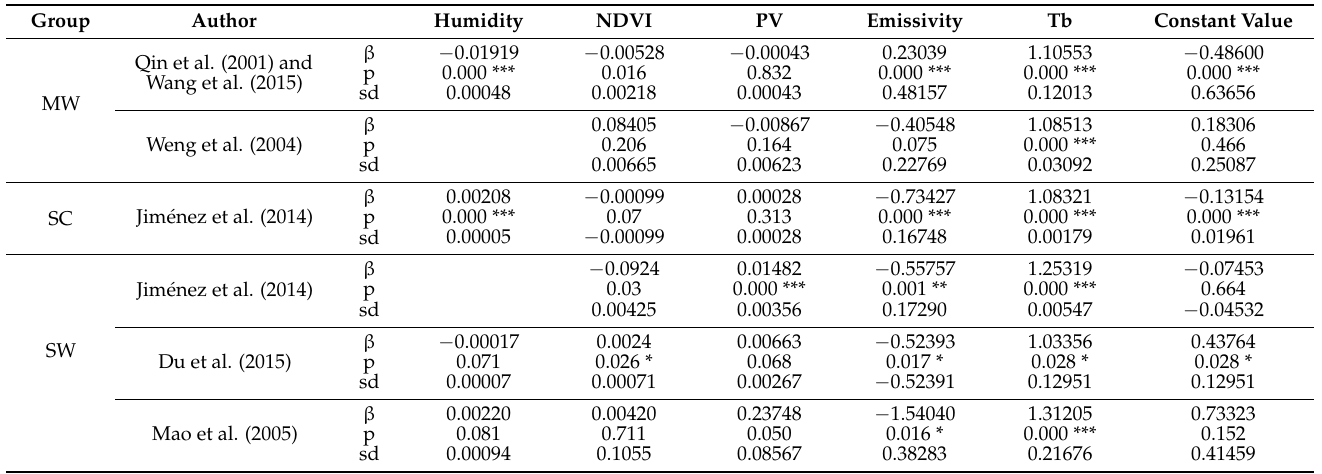
Table 8. Results of the statistical analysis using the panel data.